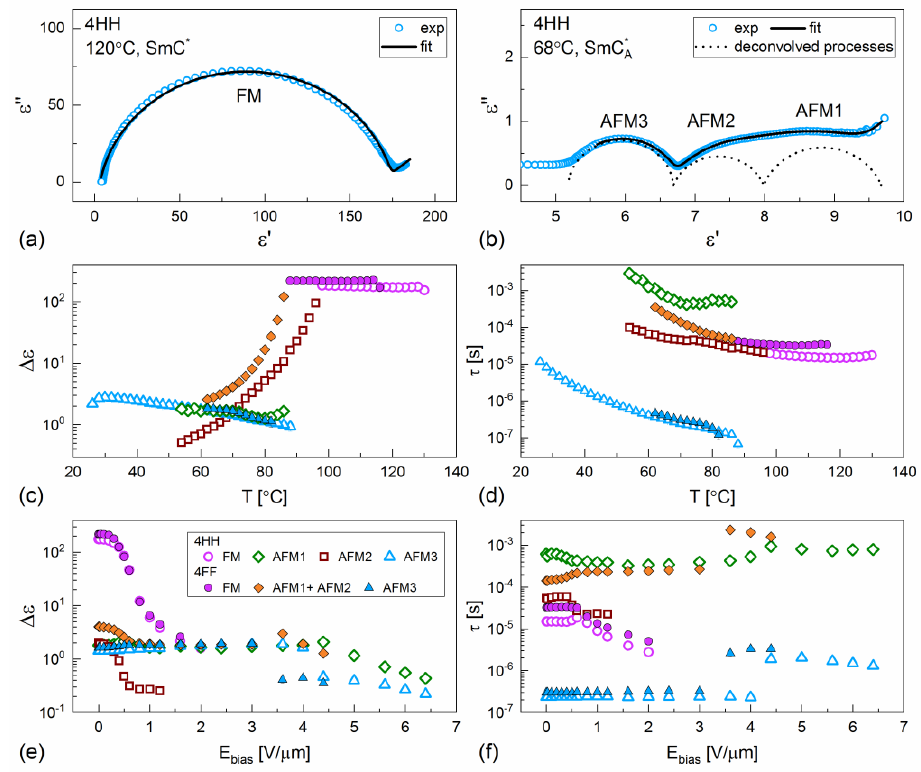
Figure 8. Relaxation processes of 4HH and 4FF observed in the SmC ∗ and SmC A∗ phases: Cole – Cole plots of FM ( a ) and AFM1, AFM2, AFM3 processes ( b ) with fitting results of Equation (1), dielectric increment ( c ) and relaxation time ( d ) of these processes vs. temperature, and dielectric increment ( e ) and relaxation time ( f ) of relaxation processes vs. bias field, for temperatures presented in Figure